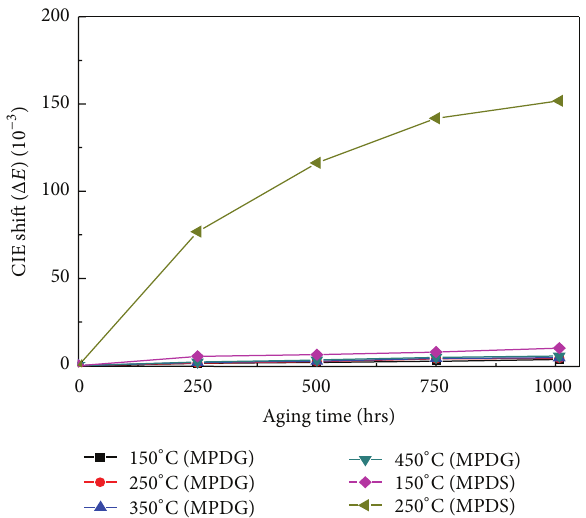
Figure 4: Chromaticity shift versus aging time for PC-WLEDs of MPDG and MPDS samples at different temperatures.